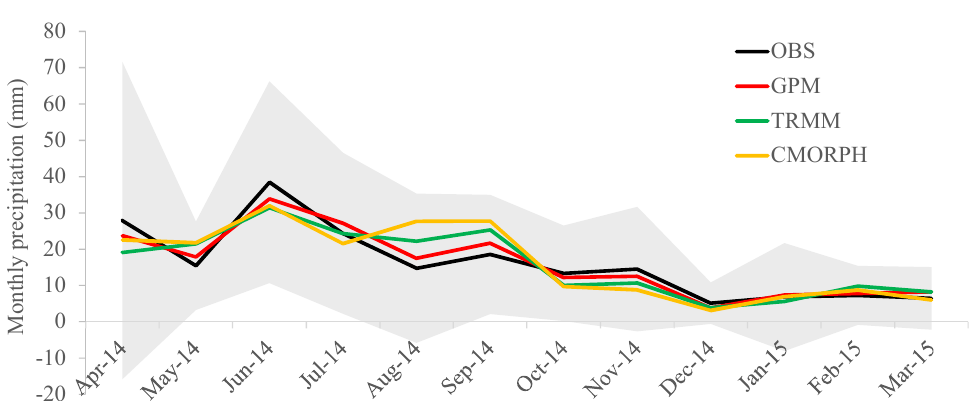
Figure 3. Comparison of the monthly precipitation patterns from the Global Precipitation Measurement (GPM), Tropical Rainfall Measurement Mission (TRMM), and Climate Prediction Center morphing technique (CMORPH) products against the OBS from April 2014 to March 2015, averaged for the 46 stations. Shaded area shows 1 standard errors (SE) of the observations. The monthly precipitation values (averaged for the 46 stations) from all satellite products fell within 1 SE of the